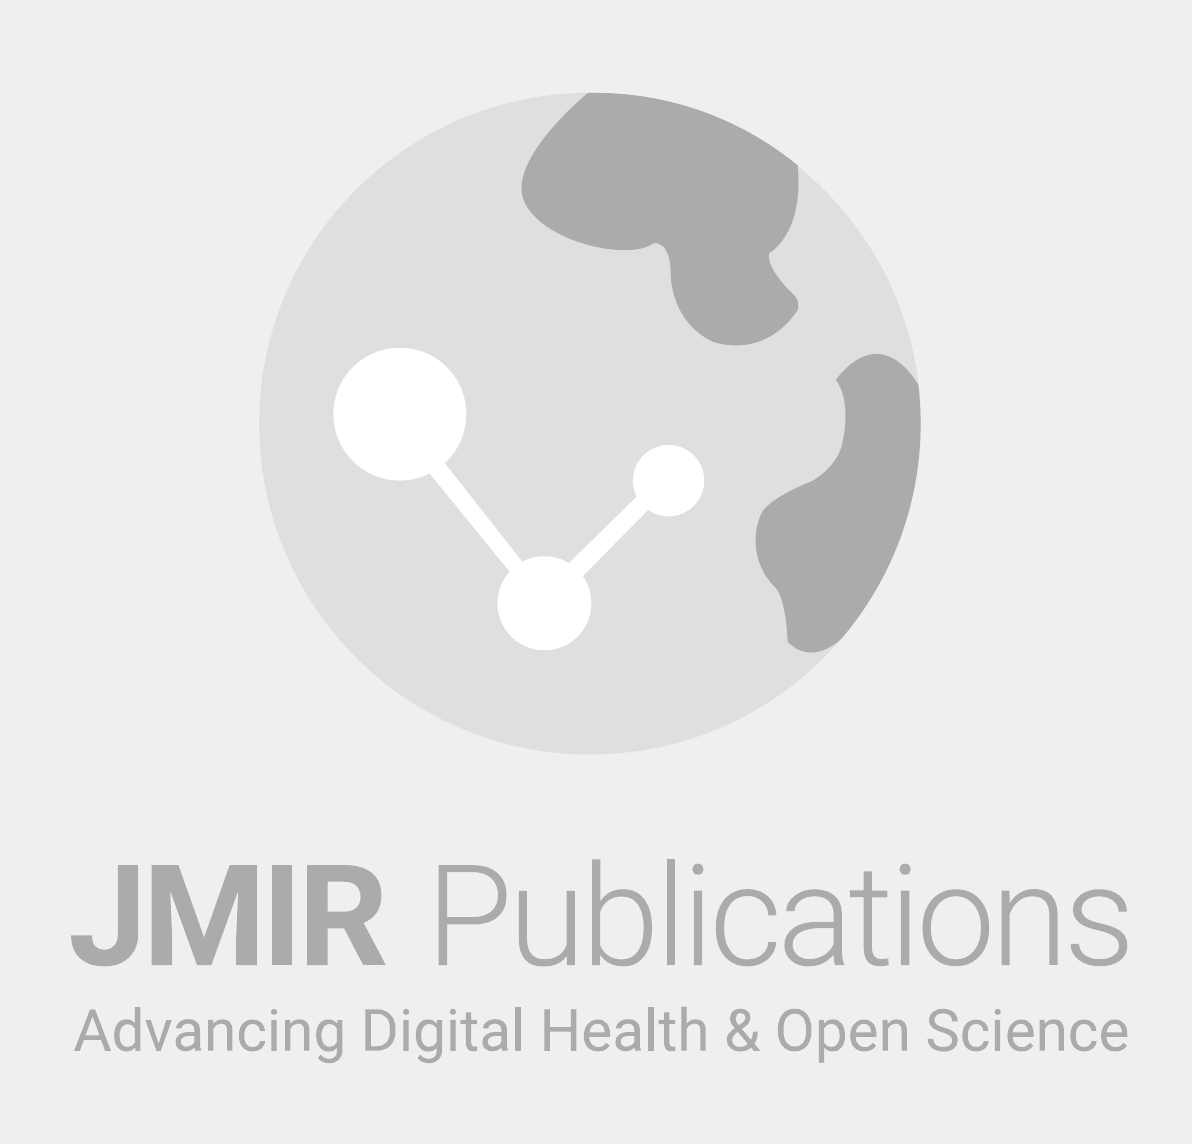
Figure 1. Article search and selection